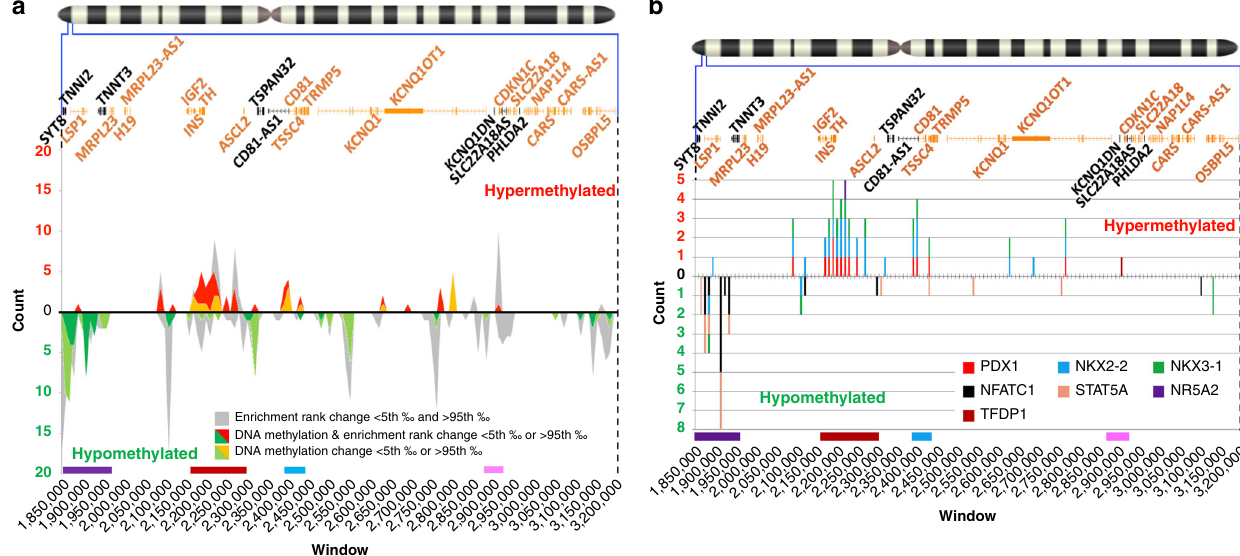
Fig. 4 Distribution of enriched and/or differentially methylated transcriptional regulator binding sites. For both panels, the chromosome 11 ideogram with a magni fi cation of the target 11p15.5-p15.4 target sub-region is as described in Fig. 1a. a Distribution of the enriched/differentially methylated transcriptional regulator binding sites across the target region. The gray, red, yellow, and green peaks display the locations of enriched/differentially methylated transcriptional regulator binding sites. The X axis shows a breakdown of the 1.35 Mbp target sub-region in 135 windows of 10 kbp each. The Y axis reports the count of transcriptional regulators per 10 kbp window. Above and below the “ 0 ” black line, the locations and number of hypo- and hypermethylated transcriptional regulator binding sites are displayed as peaks. Strong peaks of transcriptional regulator binding site hypo- and hypermethylation can be seen overlapping purple, dark red, and light blue regions de fi ned in Fig. 1b. b Distribution of differentially enriched/methylated (<5th ‰ and >95th ‰ ) transcriptional regulator binding sites. The X axis is as in a . breaks down the 1.35 Mbp target sub-region into 135 windows of 10 kbp each. The Y axis reports the count of transcriptional regulators per window. Above and below the “ 0 ” black line, the numbers of hyper- and hypomethylated transcriptional regulator binding sites are shown in the stacked histogram bars. Most of the enriched and differentially methylated transcriptional regulator binding sites reside in the purple and dark red